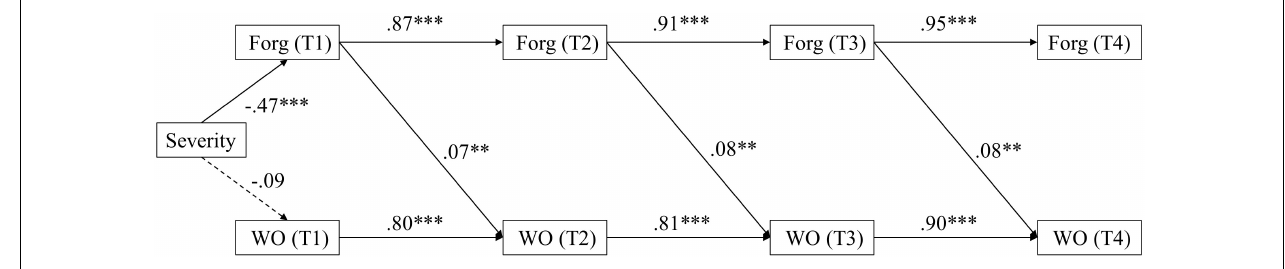
FIGURE 2 | Standardized estimates for significant paths in the forgiveness to work outcomes model. ∗ p < 0.05, ∗∗ p < 0.01, ∗∗∗ p < 0.001 (two-tailed); Forg = Forgiveness; WO = Work outcomes; T1–T4 refer to Time 1–Time 4, respectively ( N =